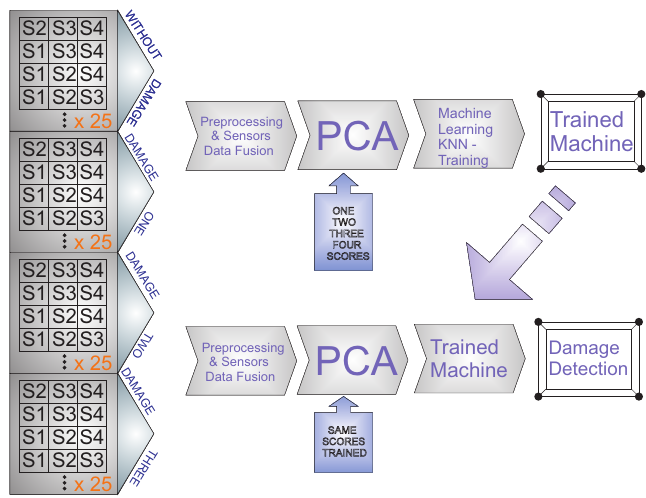
Figure 10. Feature vector organization.